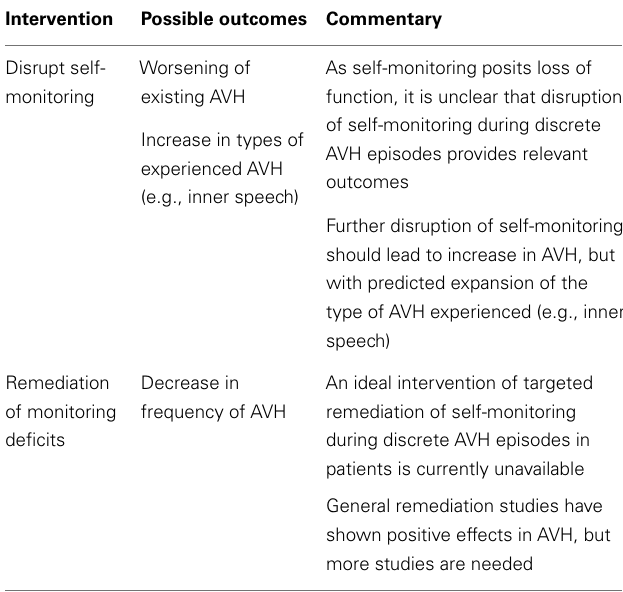
Table 2 |Auditory verbal hallucination mechanisms: testing self-monitoring account in schizophrenia